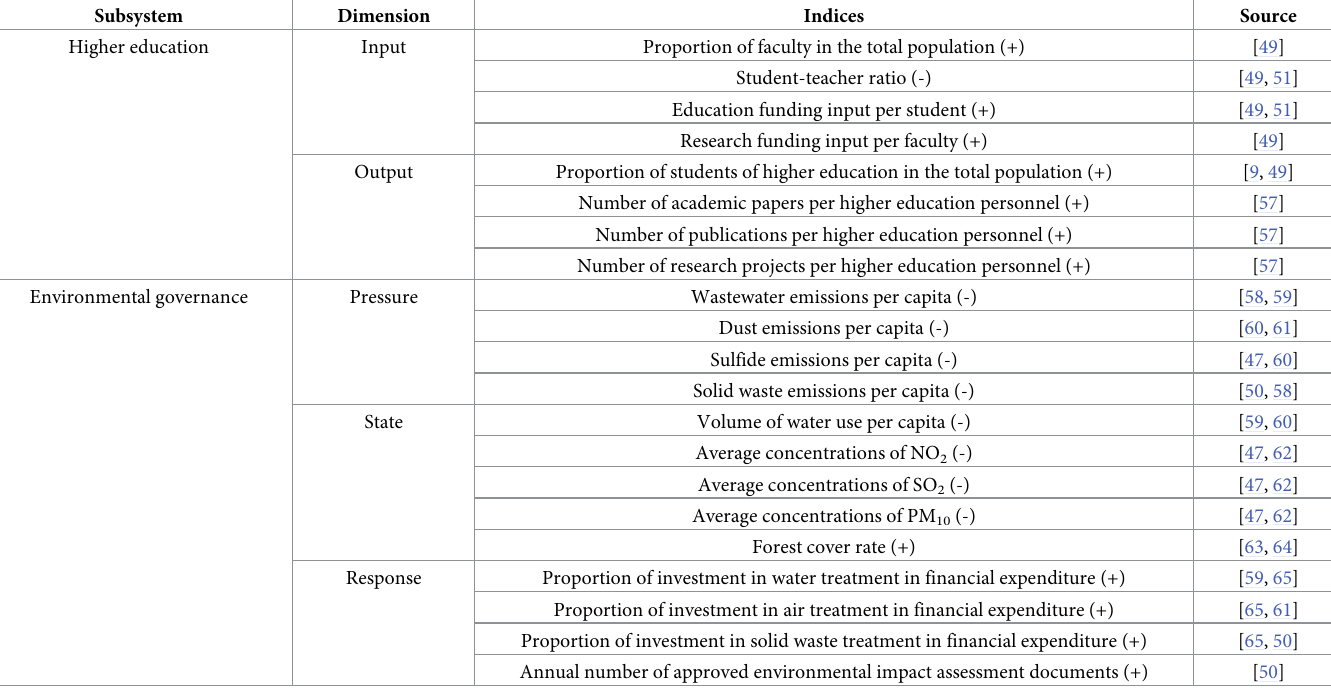
Table 1. Evaluation index system of the coupling coordination